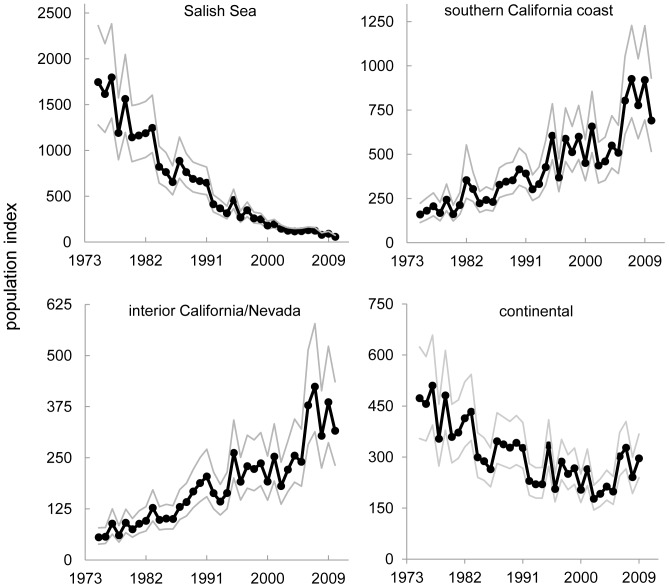
Population change of Aechmophorus grebes for the Salish Sea, southern California coast, interior California/Nevada and the continental population from 1975–2010.Population index is the predicted mean count per circle in each region controlled for survey effort. Light gray lines represent the 95% credible intervals on the mean count. Regions not shown here displayed no significant change with the exception of the southwestern states. Western grebes comprised >99% of the Aechmophorus spp. observations in the Salish Sea and 91–97% in the other two regions.